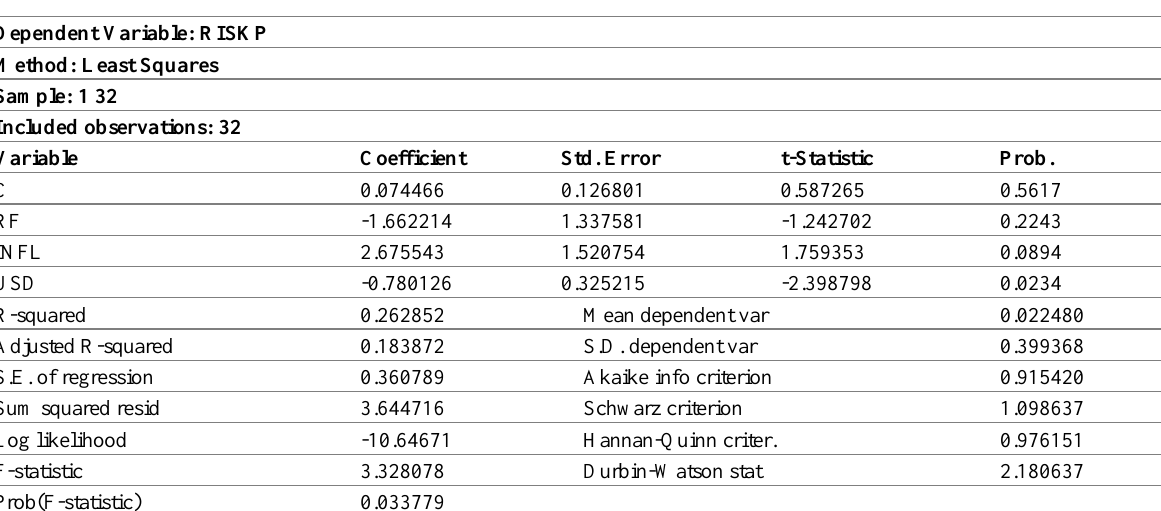
Table 3: Test Results for the Effect of Interest Rates, Inflation, and Exchange Rates on Risk